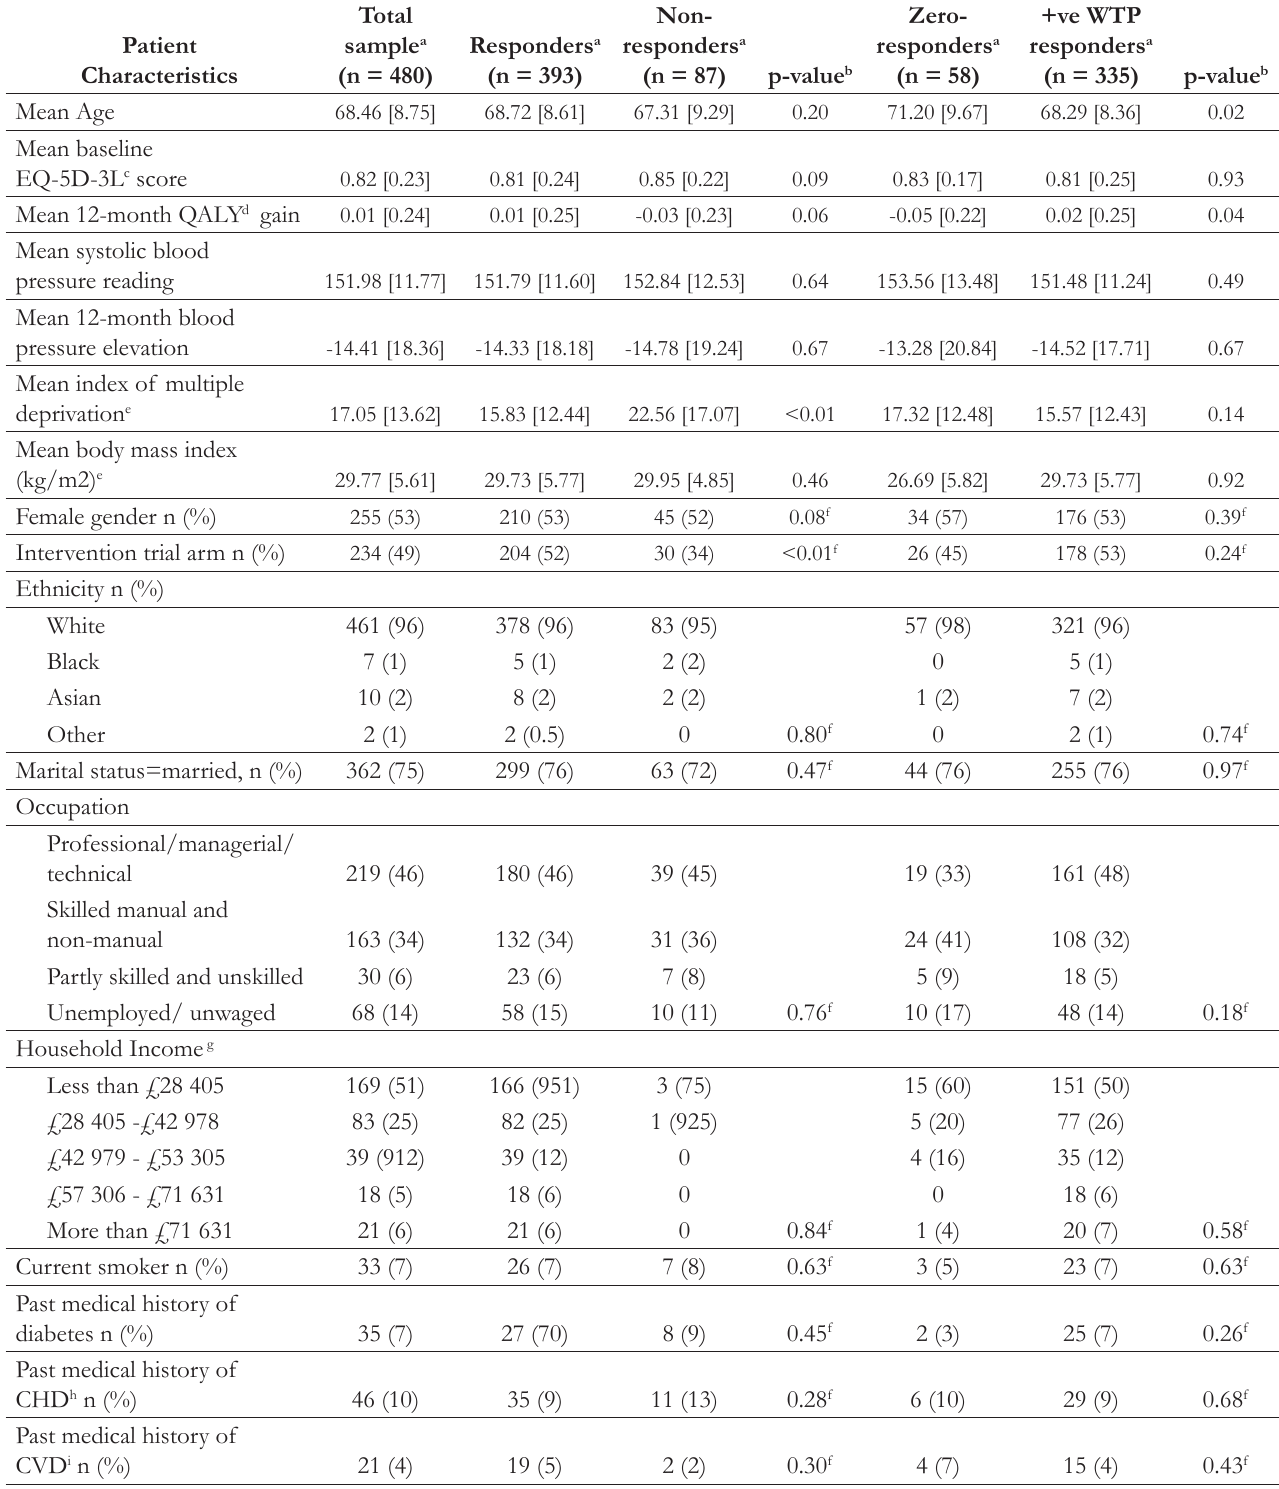
Table 1. Baseline Patient Characteristics for Total Sample, WTP Questionnaire Responders and WTP Questionnaire